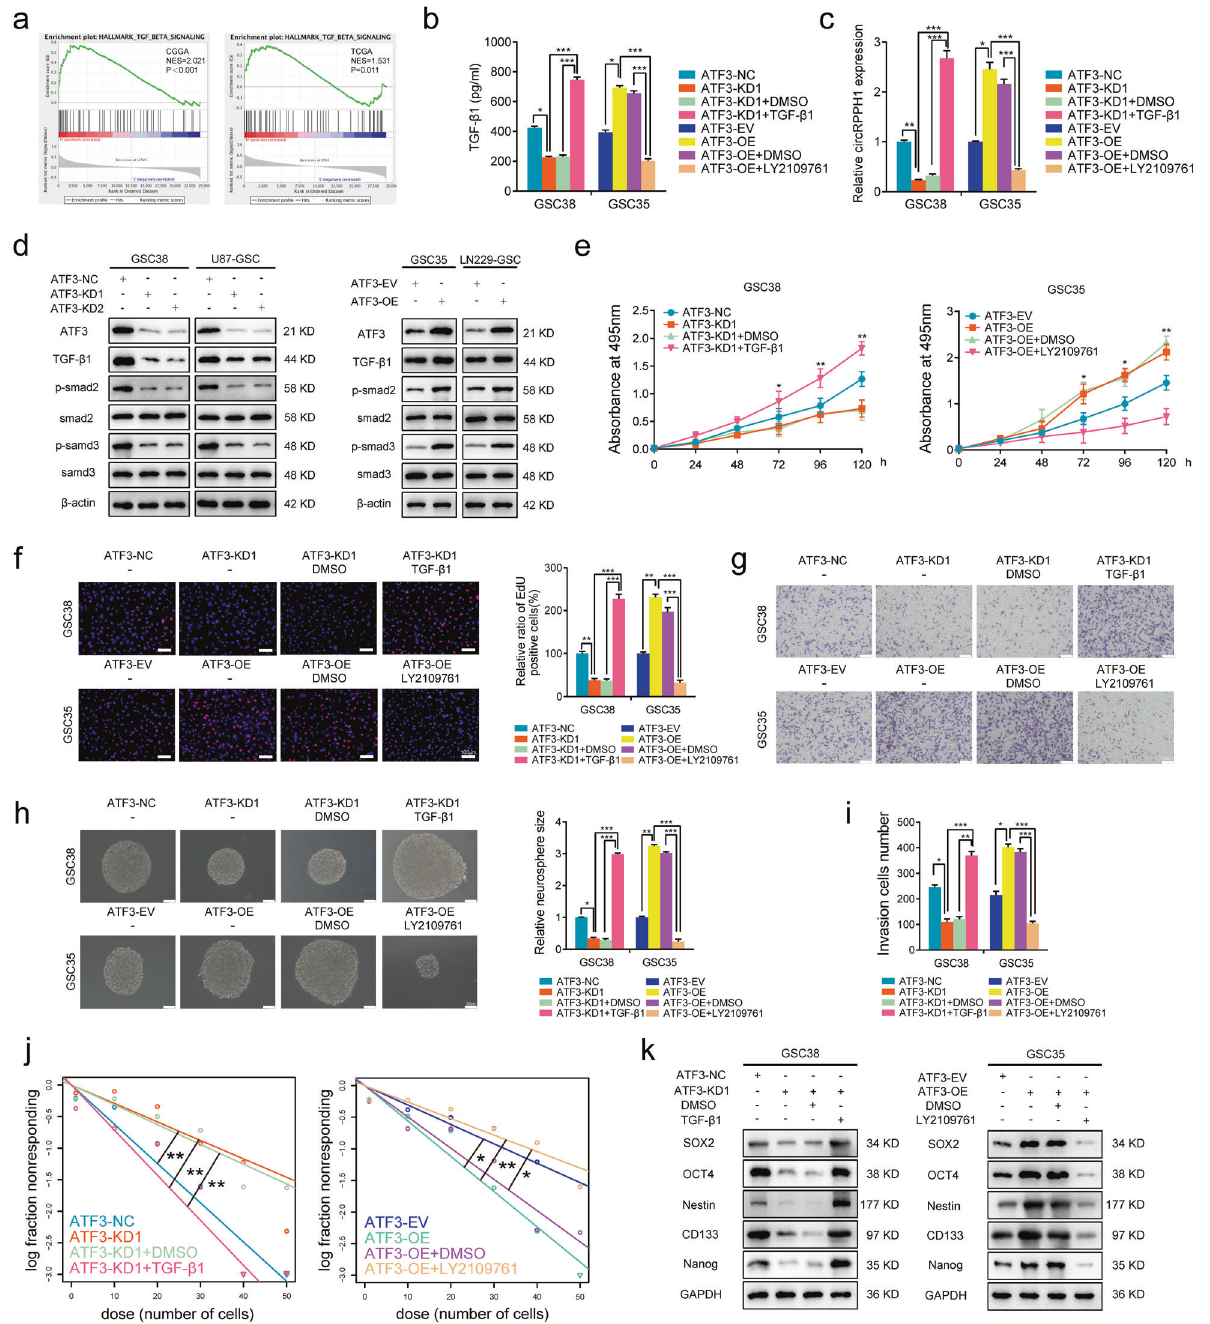
Fig. 7 ATF3 can promote the malignant phenotype of GSCs via activating TGF- β 1/Smad2 signaling. a Gene set enrichment analysis (GSEA) showed that high expression of ATF3 is positively associated with the TGF- β signaling pathway through data from the TCGA and CGGA datasets. (CGGA: p < 0.01; TCGA: p = 0.011). b ELISA assays detected the secretion of TGF- β 1 after ATF3 knockdown or overexpression. (GSC38: p < 0.001; GSC35: p < 0.001; One-Way ANOVA). c The expression of circRPPH1 after ATF3 knockdown or overexpression with TGF- β 1 or LY2109761 was detected by qPCR. (GSC38: p < 0.001; GSC35: p < 0.001; One-Way ANOVA). d Western blotting showed that ATF3-KD mediated the less expression of p-smad2 and p-smad3, while ATF3-OE elevated them. e MTS assays showed that the cell viability of ATF3-KD GSCs was improved by TGF- β 1 treatment. And LY2109761 could inhibit the cell viability of ATF3-OE GSCs. (GSC38: p < 0.01; GSC35: p < 0.01; One-Way ANOVA). f , g , i EdU assays and Transwell assays showed the proliferation and invasion abilities of ATF3-KD GSCs were enhanced under TGF- β 1 treatment. LY2109761 inhibited them in ATF3-OE GSCs Scale bar = 100 μ m. (GSC38: p < 0.001; GSC35: p < 0.001; One-Way ANOVA). h, j Neurospheres formation assays and extreme limiting dilution analysis revealed that the sphere-forming and self-renewing capacity of ATF3- KD GSCs were enhanced under TGF- β 1 treatment. LY2109761 could inhibit them in ATF3-OE GSCs Scale bar = 100 μ m. (GSC38, kd vs. nc: p = 0.00621, kd vs. kd + TGF β 1: p = 0.0011; kd + DMSO vs. kd + TGF β 1: p = 0.00228; GSC35, oe vs. ev: p = 0.0259, oe vs. oe + LY2109761: p = 0.00534, oe + DMSO vs. oe + LY2109761: p = 0.0184; ELDA analysis; circles represent corresponding points, triangles mean the point is outside of the log fraction number wells). k Western blotting showed that the stemness markers expression in ATF3-KD GSCs was upregulated by TGF- β 1 treatment. And LY2109761 could inhibit the expression in ATF3-OE GSCs. All results are obtained as the mean ± SD under at least biological triplicate assays. * p < 0.05, ** p < 0.01, *** p < 0.001. Cell Death and Disease (2022)